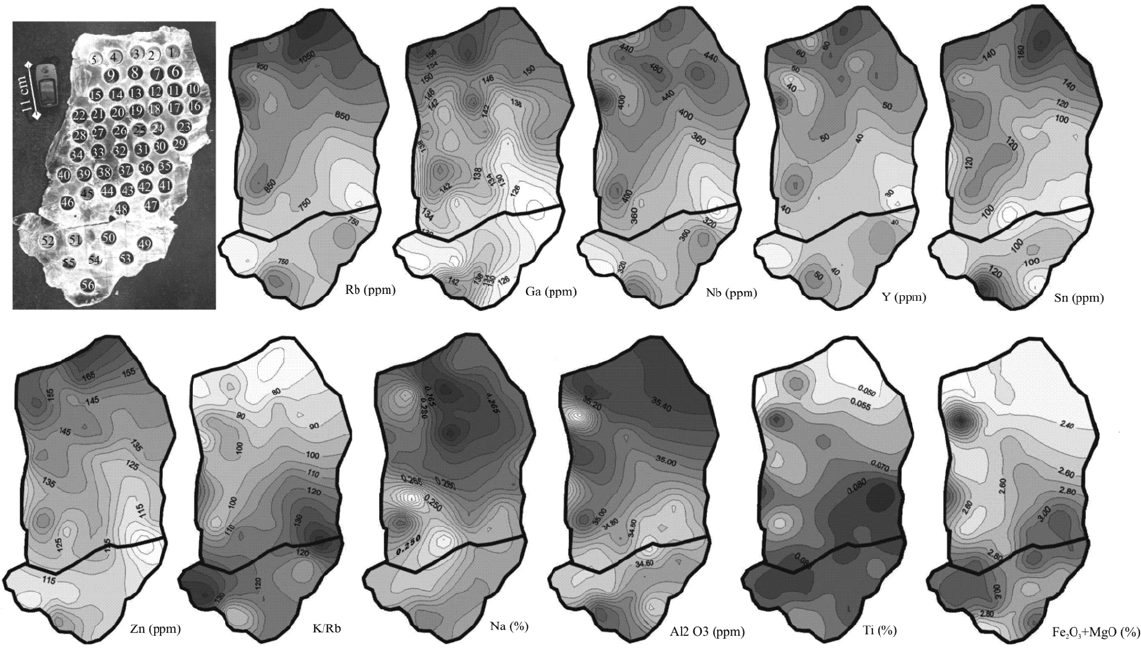
Fig. 3 – Sketch of studied muscovite plate with location of the analyzed points and distribution maps of the compositional contour lines for selected elements.